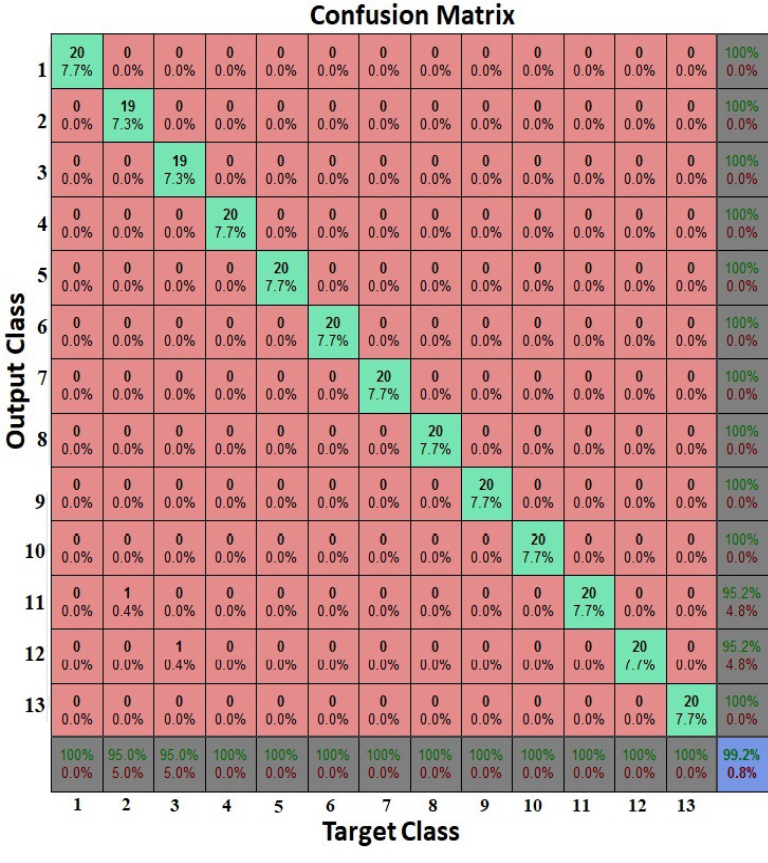
Figure 11. Confusion matrix for the ANN training